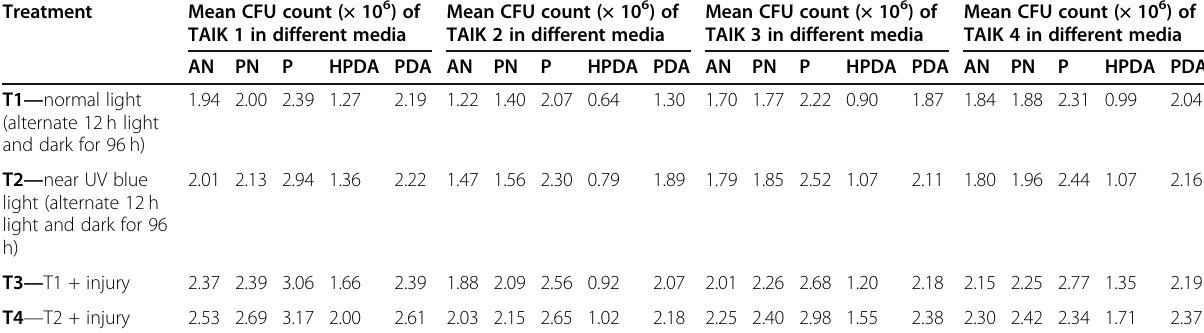
Table 3 Interaction studies of different stimuli on mean CFU count of selected potential isolates of T. asperellum Treatment Mean CFU count (× 10 6 ) of Mean CFU count (× 10 6 ) of Mean CFU count (× 10 6 ) of Mean CFU count (× 10 6 ) of TAIK 1 in different media TAIK 2 in different media TAIK 3 in different media TAIK 4 in different media HPDA PDA AN PN